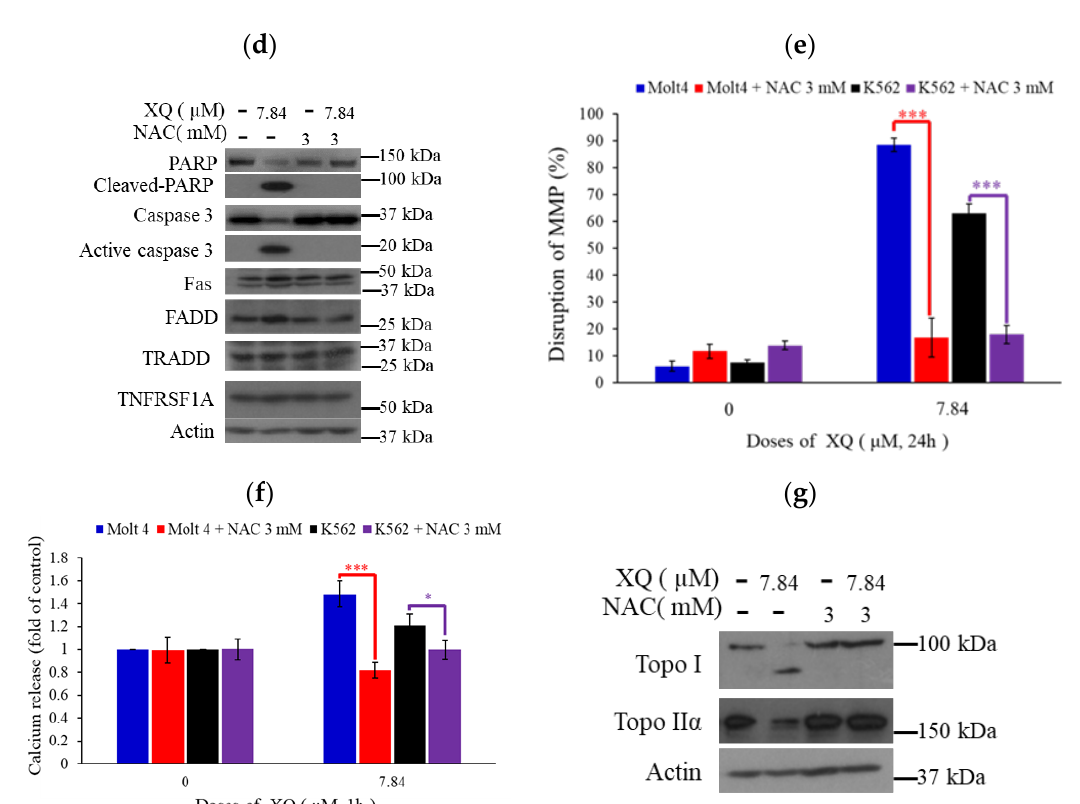
Figure 7. XQ-induced apoptosis in leukemia cells involved the promotion of ROS generation. ( a ) Leukemia Molt-4 cells were treated with XQ for 30 min. The concentration of ROS was detected by flow cytometry. H 2 O 2 was used as the positive control. ( b ) Leukemia Molt-4 and k562 cells were pretreated with NAC for 30 min followed by XQ treatment for 30 min. The concentration of ROS was detected by flow cytometry. Molt-4 leukemia cells were pretreated with NAC for 30 min followed by XQ treatment for 24 h. ( c ) The annexin-V expression was detected by flow cytometry. (d) Whole-cell lysates were collected. The effect of XQ on apoptosis-related proteins was evaluated by Western blotting. ( e ) The leukemia cells were pretreated with NAC for 30 min followed by XQ treatment for 24 h. The changes in MMP were detected by flow cytometry. ( f ) The cells were treated with NAC for 30 min followed by XQ treatment for 1 h, and the calcium release from ER into the cytosol was evaluated. ( g ) Leukemia cells were pretreated with NAC for 30 min followed with XQ for 24 h, and the whole-cell lysates were collected. The protein expressions of Topo I and Topo II α were detected by Western blotting; * p < 0.05, ** p < 0.01, and *** p < 0.001. Actin was used as the loading control.